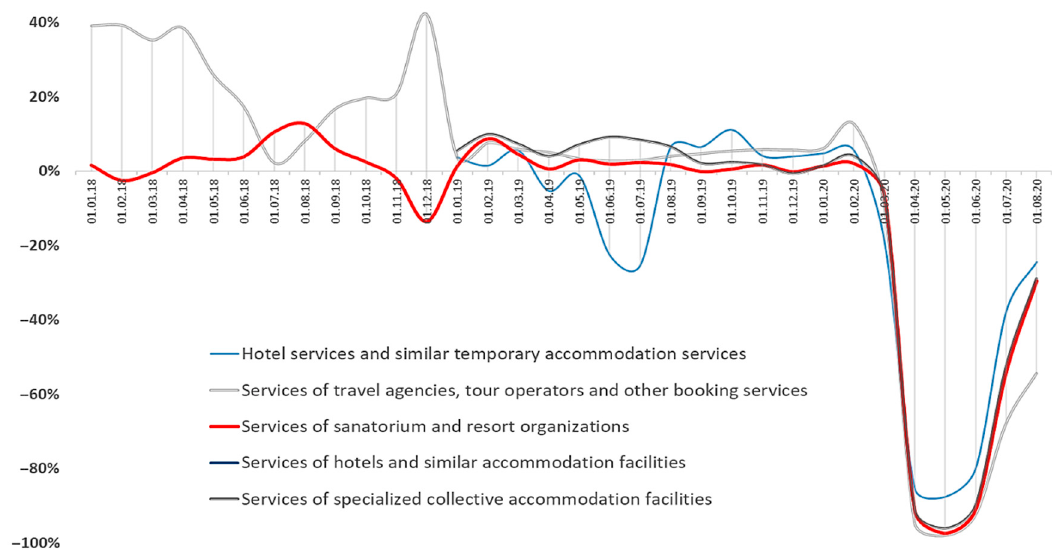
Figure 4. The growth rate of services provided by the Russian tourism and hospitality industry, 2020 compared to the same period of the 2019 year (Rosstat 2020).